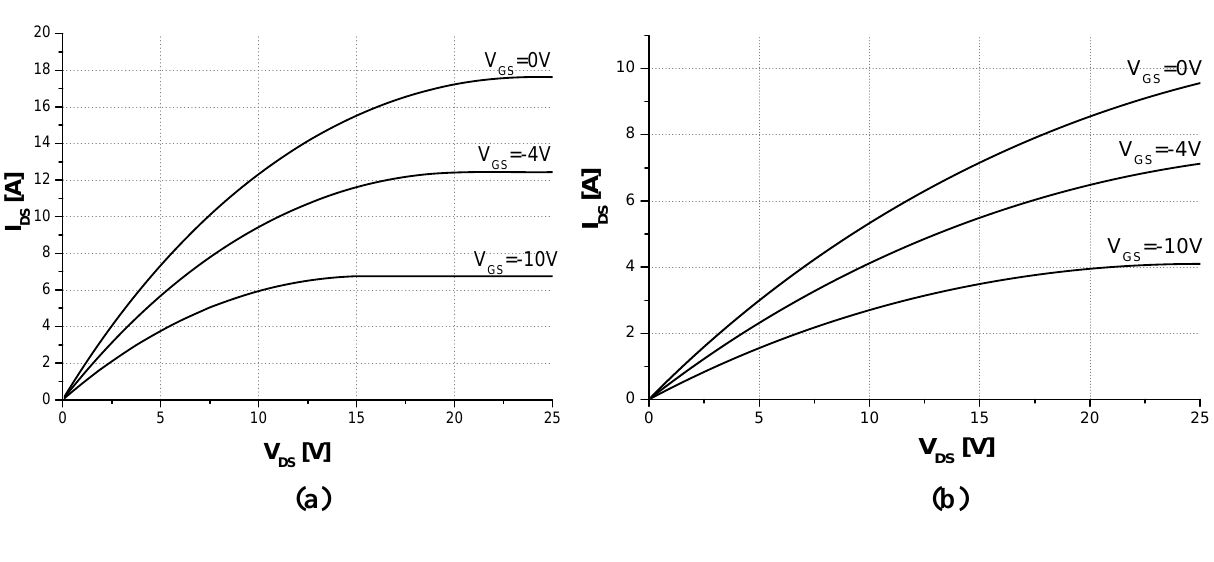
= 5 × 10 16 cm –3 , DL